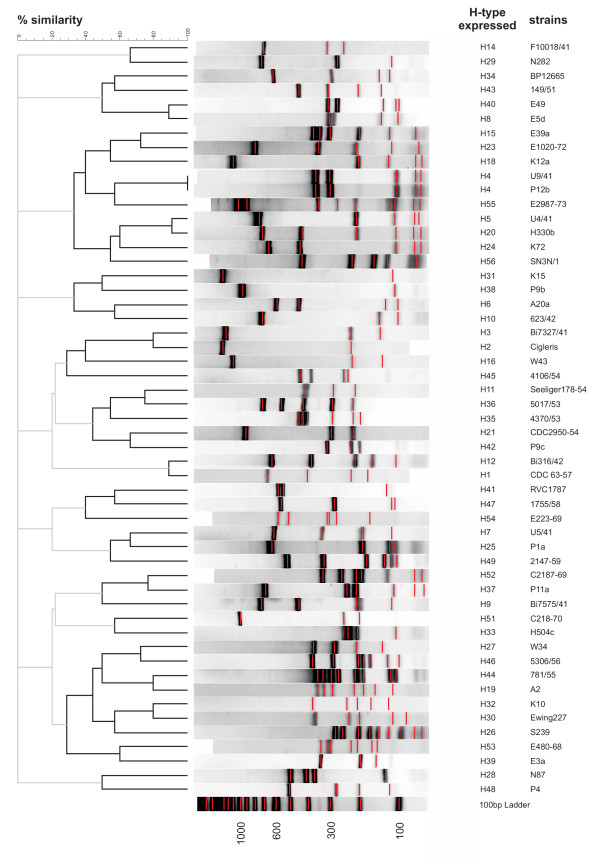
HhaI digested fliC PCR products obtained with primers fliC-1 and fliC-2 from E. coli reference strains for 53 different expressed H-types as indicated at the right side. Similarity of restriction fragment patterns was calculated with BioNumerics software and is indicated by the dendrogram on the left side. The flagellar antigens of strains encoding H-types H3, H17, H35, H36, H44, H47, H53, H54 and H55 are not encoded by fliC but by other genes (flkA, fllA, flmA and others) in the corresponding E. coli strains and the fliC HhaI patterns obtained from these strains do therefore not correspond to their H-serotypes [21, 25, 26, 27].